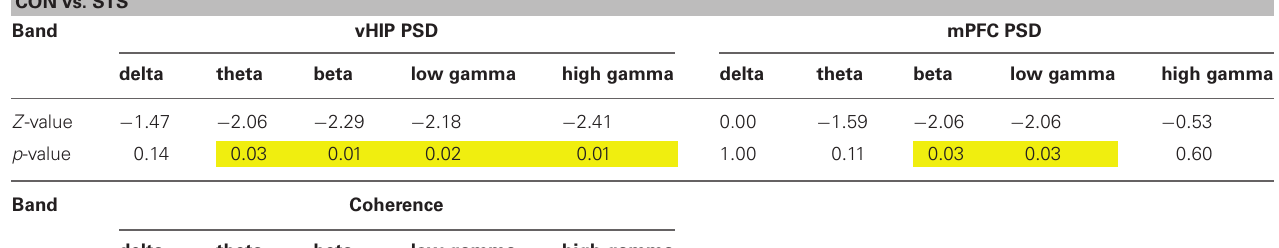
Table 1 | Statistical values of the group comparisons of PSD and coherence for each frequency band in the first set of animals. CON vs. STS